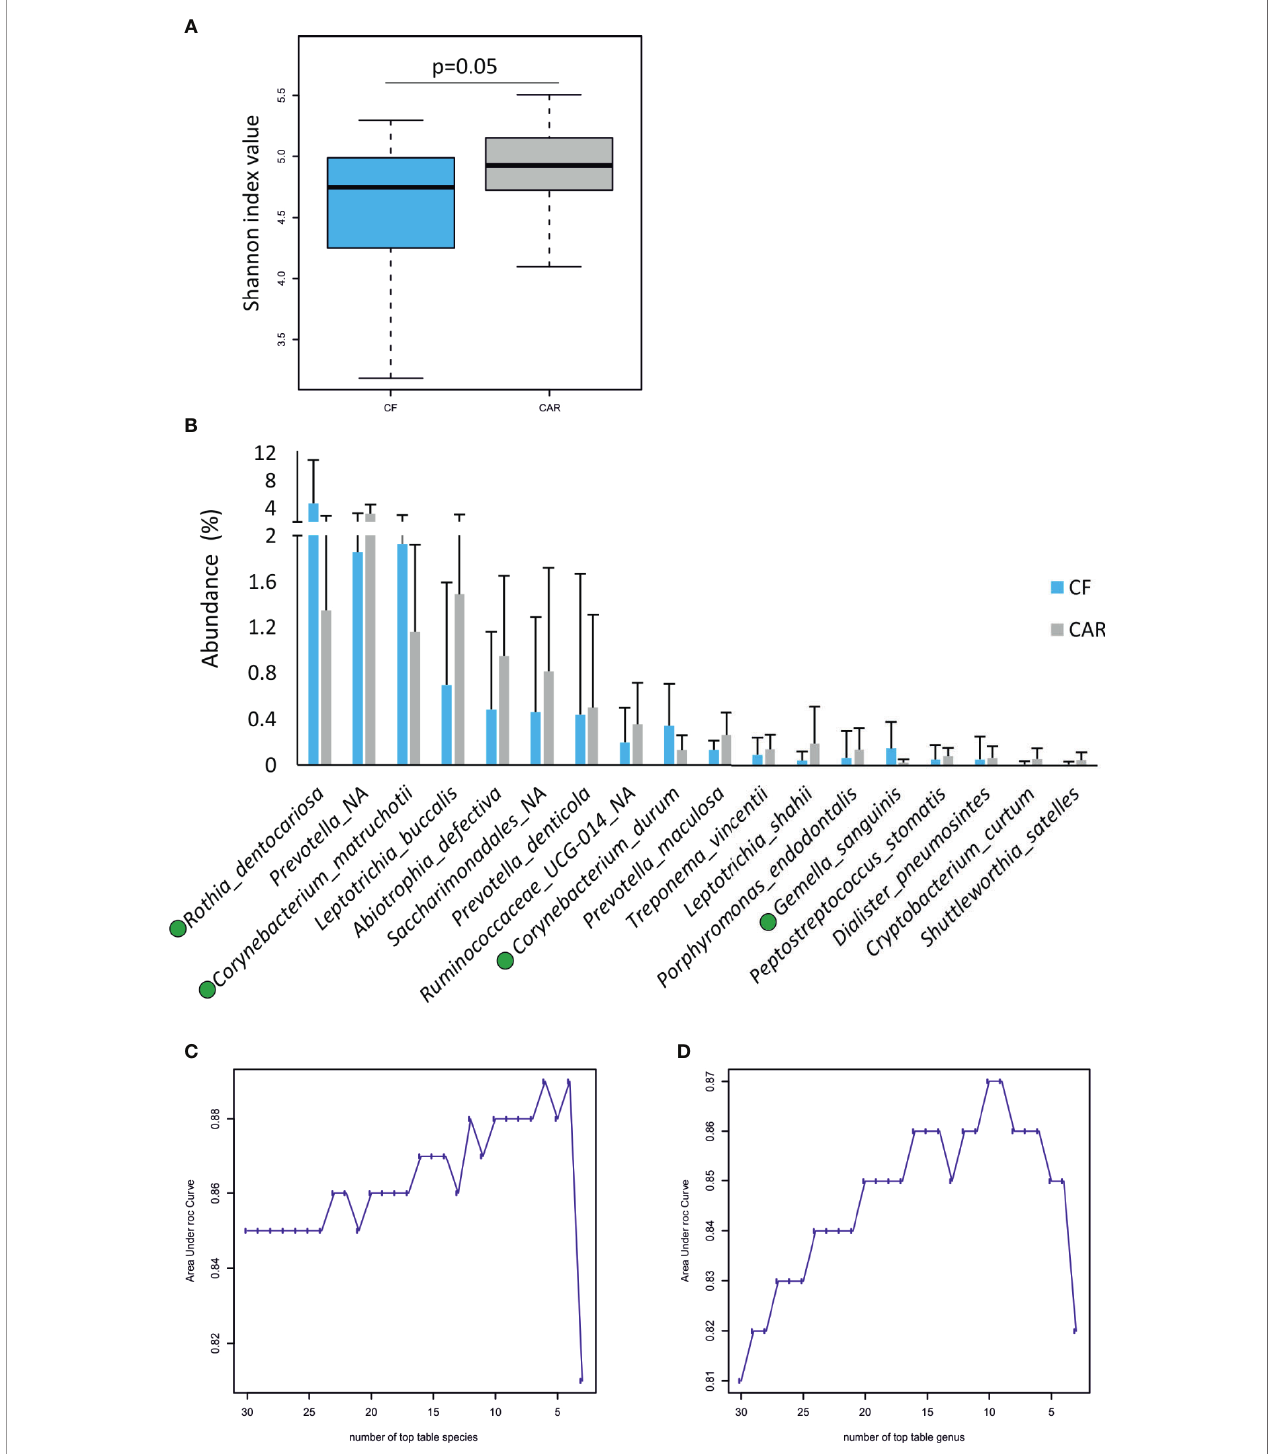
FIGURE 2 | Microbiology of dental plaque samples from caries-experienced (CAR) and caries-free (CF) adolescents, as obtained by sequencing of the 16S rRNA gene. (A) Boxplots show diversity (Shannon) and richness (Chao1) indexes in CAR and CF individuals. The p-values (Wilcoxon test) are indicated. (B) Mean abundance of bacterial species found at signi fi cantly different proportions in either CF or CAR groups (p-values <0.05, Wilcox test). Bacteria over-represented in CF individuals are highlighted by a green dot. Lower plots represent the accuracy (Area under Curve) of random forest models to discriminate between CAR and CF individuals according to the number of bacterial species (C) and genera (D)